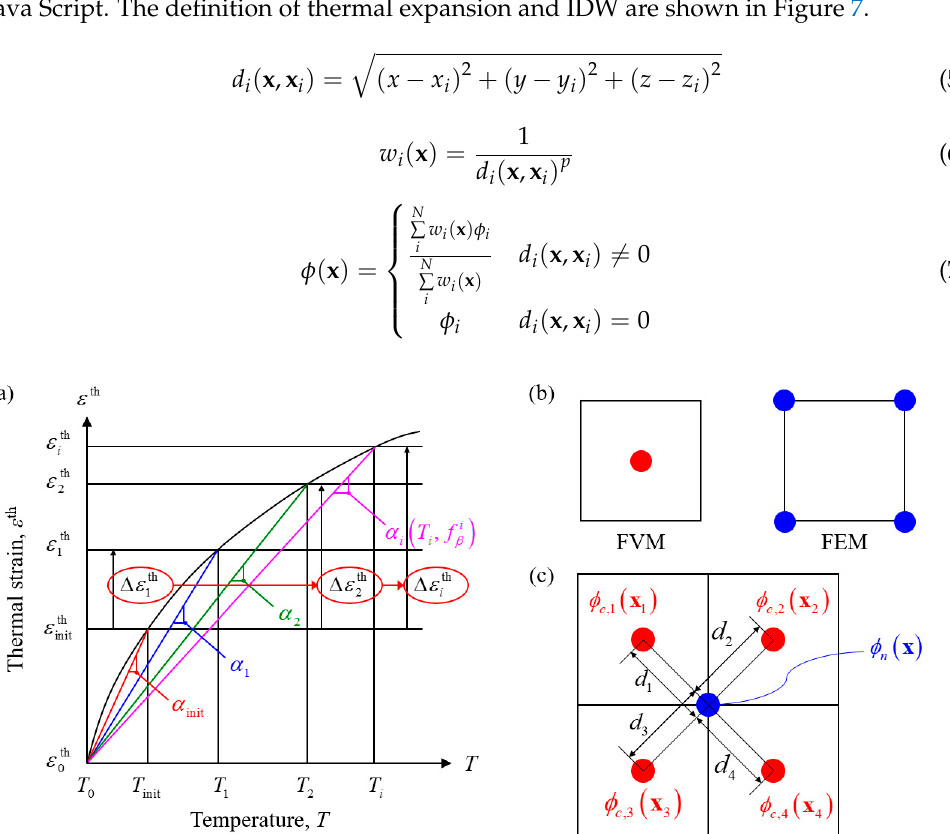
The temperature distributions were interpolated to match the computational points of FVM and FEM by the IDW method. The distance between the target and nearby points is calculated and multiplied by the weight function. Interpolated values are obtained utilizing Java Script. The definition of thermal expansion and IDW are shown in Figure 7.